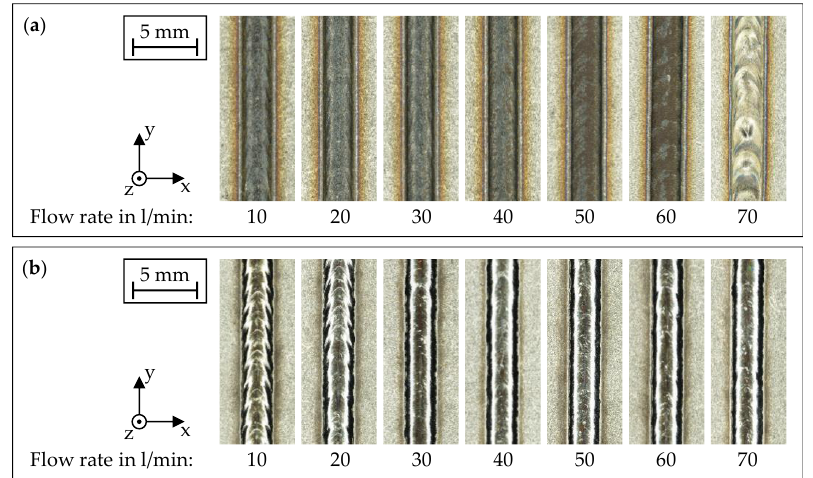
Figure 8. Surfaces of individual weld beads deposited at shielding gas flow rates ranging from 10 l/min to 70 l/min using ( a ) the lateral nozzle and ( b ) the optimized nozzle.